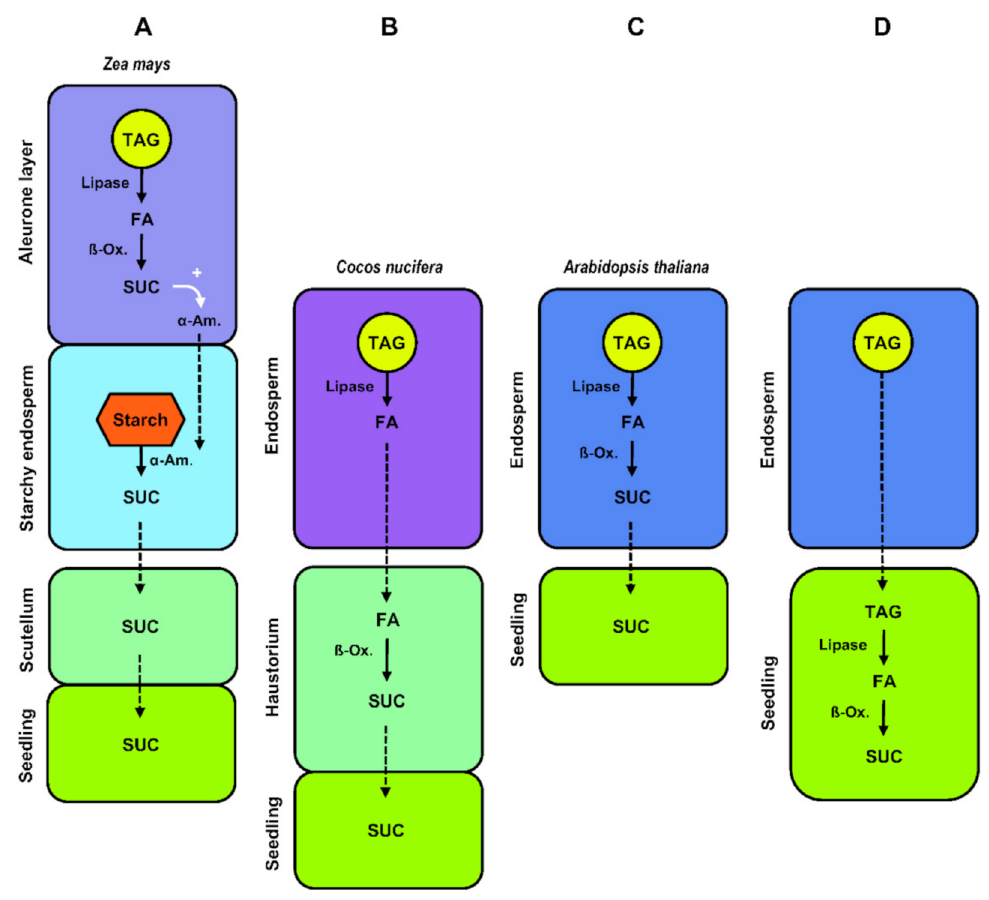
Figure 5. Oil mobilization in germinating seeds. The schemes illustrate different strategies for the mobilization of storage lipids and the allocation of carbon to the seedling. ( A ). In the aleurone layer of cereal grains, lipid mobilization supports the synthesis of α -amylases that are secreted into the dead starchy endosperm to mobilize starch, releasing nutrients that are absorbed by the scutellum. ( B ). In non-cereal monocots in the family Aracaceae, fatty acids released from triacylglycerol by lipases in the endosperm are thought to be transported to the haustorium, where enzymes of ß-oxidation are located. ( C ). In seeds of oleaginous dicots, triacylglycerol mobilization and gluconeogenesis take place in the endosperm and sugars are transported to the seedling. ( D ). Although this hypothesis remains to be validated, direct supply of triacylglycerol from the endosperm to the seedling was also proposed. Abbreviations: α -Am, α -amylase; ß-ox., ß-oxidation; FA, fatty acid; SUC, sucrose; TAG,